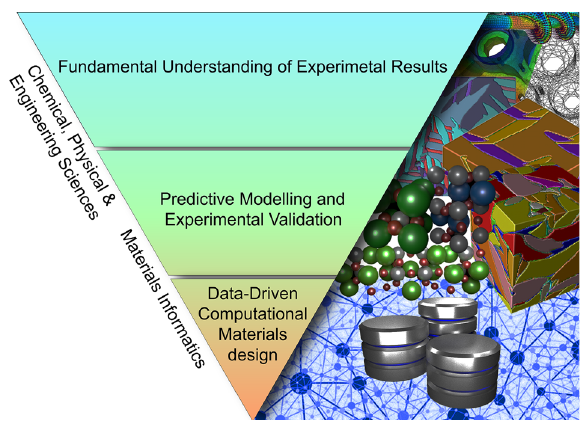
Fig. 1 Illustration of three primary roles of computational modeling in materials research and design